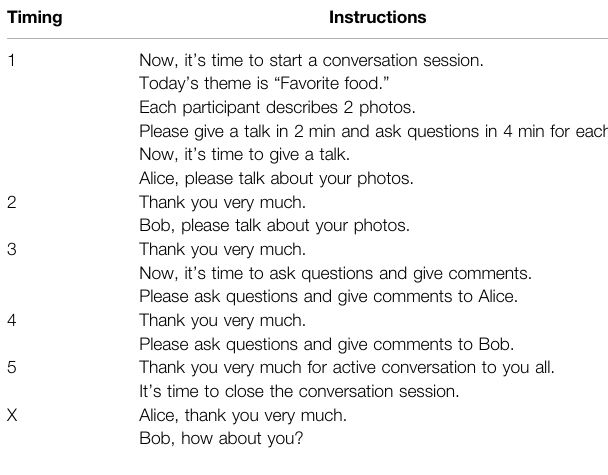
TABLE 2 | Instructions given by the